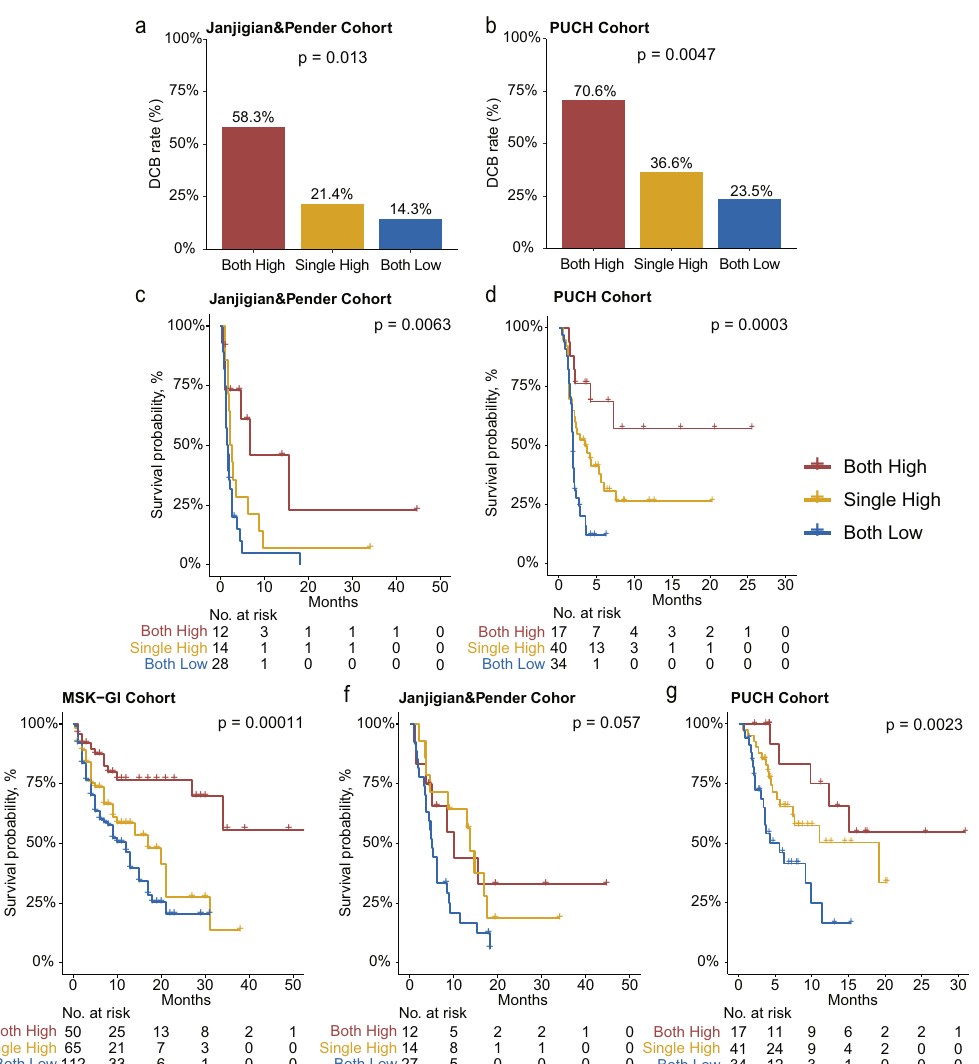
Fig. 3 The joint utility of GIPS and TMB in predicting the clinical outcomes of patients with gastrointestinal cancer receiving ICI treatment. a , b Proportion of patients with DCB calculated within each of the three indicated subgroups. c , d Kaplan – Meier survival analysis of PFS among patients within each of the three indicated subgroups in the Janjigian and Pender ( c ) and in the PUCH ( d ) cohorts. e – g Kaplan – Meier survival analysis of OS among patients within each of the three indicated subgroups in the MSK-GI ( e ), Janjigian and Pender ( f ), and PUCH ( g ) cohorts. For Janjigian and Pender cohort, 53 patients had OS information. For PUCH cohort, 91 patients had PFS